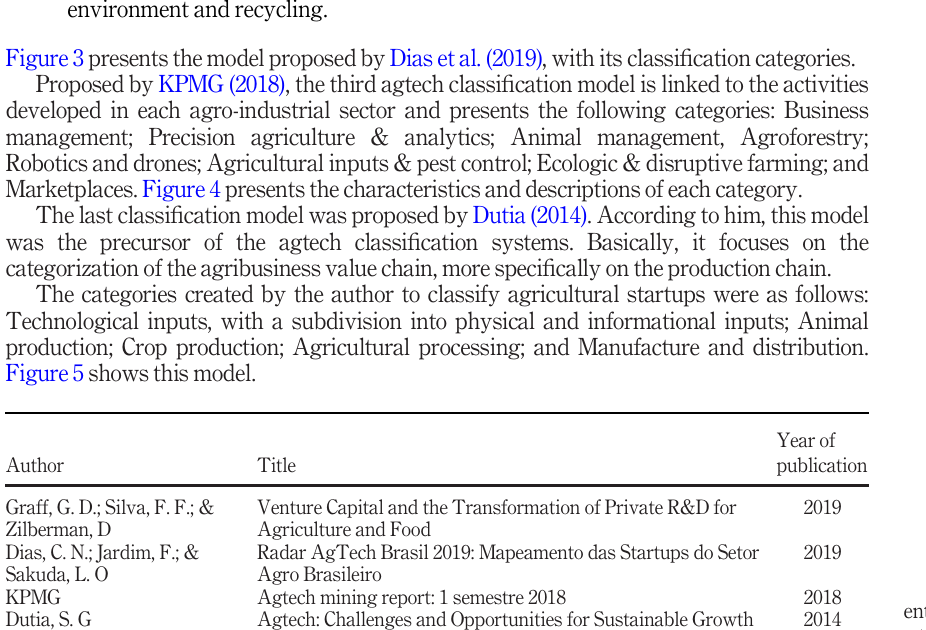
Table 1. Identi fi cation